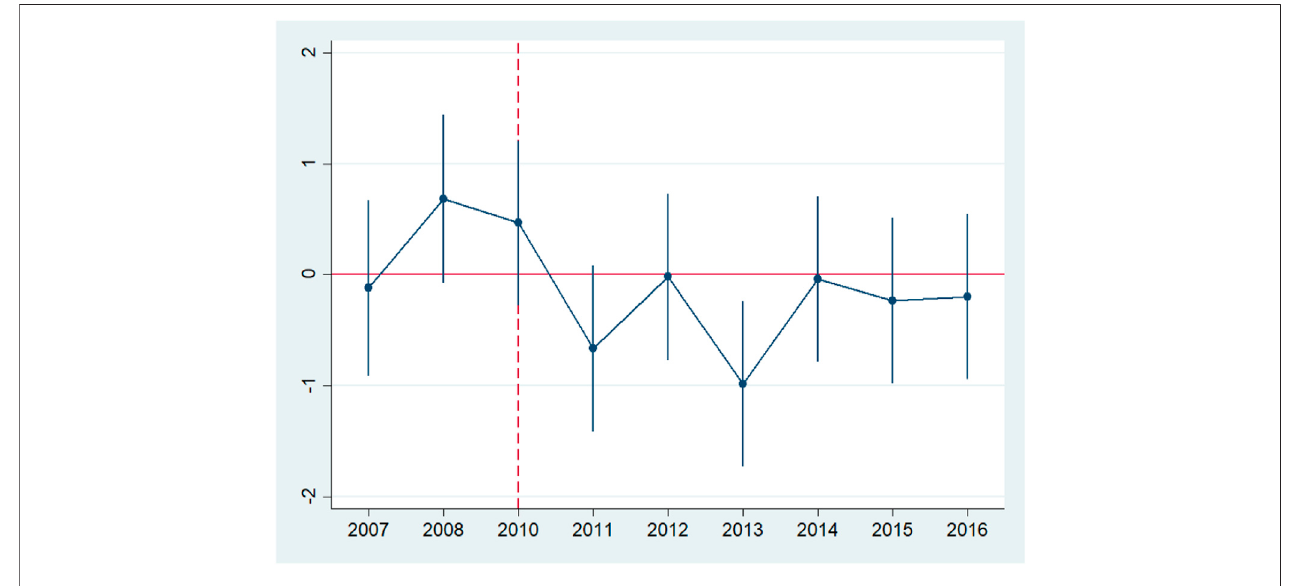
FIGURE 2 | Results of parallel trend test.